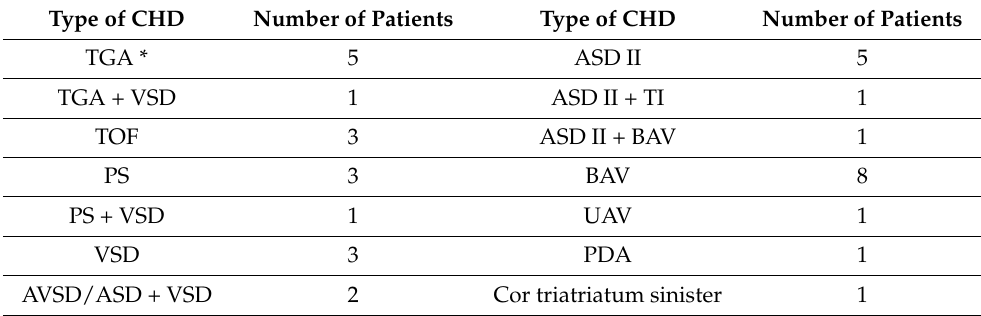
Table 2. Occurrence of different types of CHD.